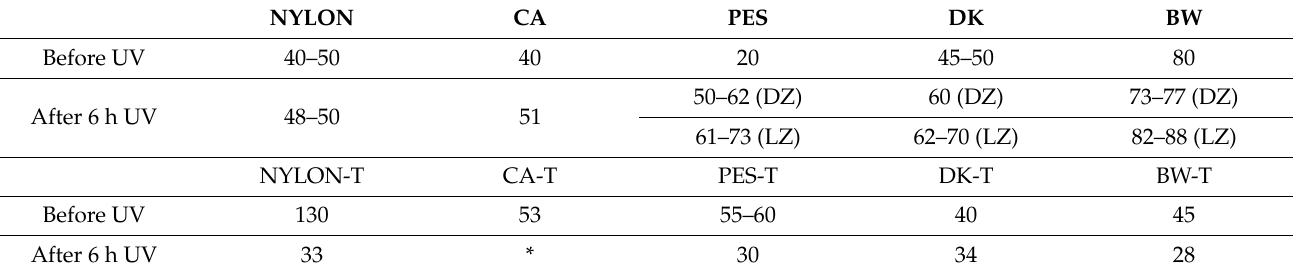
Table 2. Dynamic contact angles for unmodified and modified polymeric membranes (sol–gel modification with TiO 2 nanoparticles) before and after UV exposure, n =